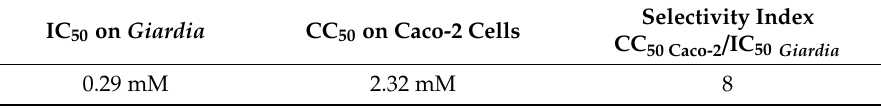
Figure 1. In vitro effect of ASA on Giardia lamblia trophozoites after incubation for 12, 24 and 48 h. Growth ( A ), percentage of growth inhibition ( B ), adhesion ( C ) and viability ( D ). The results represent the mean of triplicate determinations ± SD. (* p < 0.0006, # p < 0.005, ** p < 0.0001). Table 1. Antigiardial, cytotoxicity and selectivity index values of acetylsalicylic acid